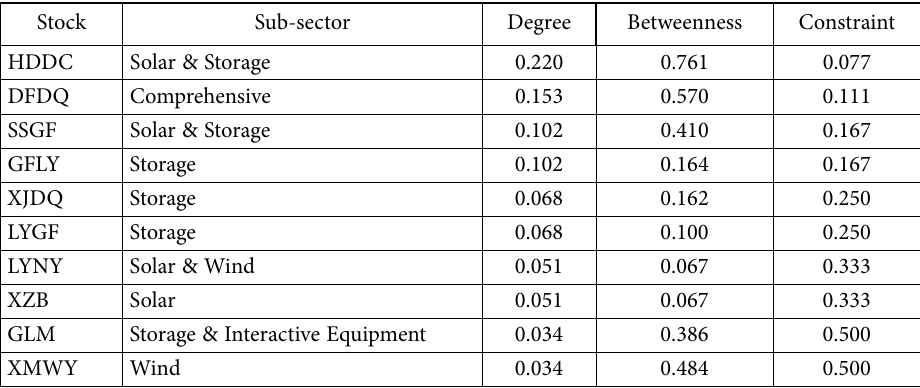
Table 2. The top 10 influential stocks and topological